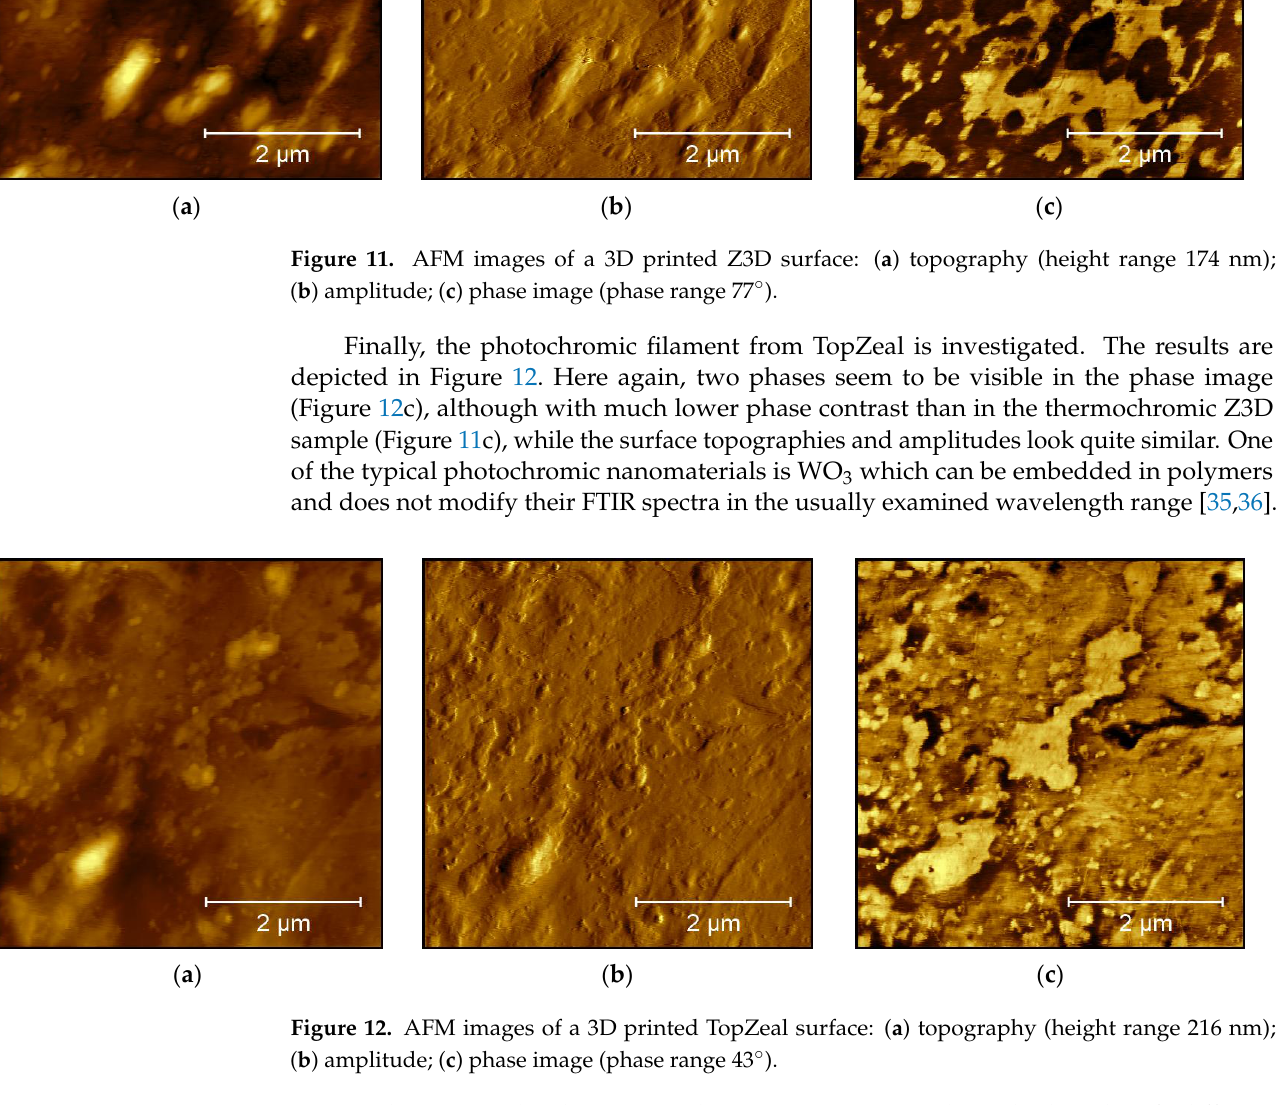
( c ) Figure 10. AFM images of a 3D printed PLA “UV” surface, taken at another position: ( a ) topogra- phy (height range 265 nm); ( b ) amplitude; ( c ) phase image (phase range 26°). Next, the thermochromic filament Z3D is investigated by AFM. As Figure 11 shows, the surface structure looks different from the previous thermochromic and photochromic filaments, as visible in the topography (Figure 11a) and amplitude (Figure 11b). More interestingly, the phase image (Figure 11c) shows a clear phase separation. This finding was verified at 20 different sample positions to exclude the possibility that erroneous contamination was measured. The large area of the second phase, verified by the other AFM images, is nevertheless unexpected since no second material was visible in the FTIR measurements (Figure 4), and the material should consist of PLA only, according to the material specifications from